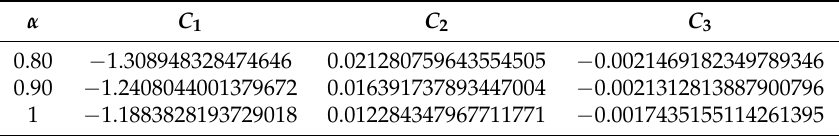
Table 6. Auxiliary Convergence-constants for dissimilar values of α of Example